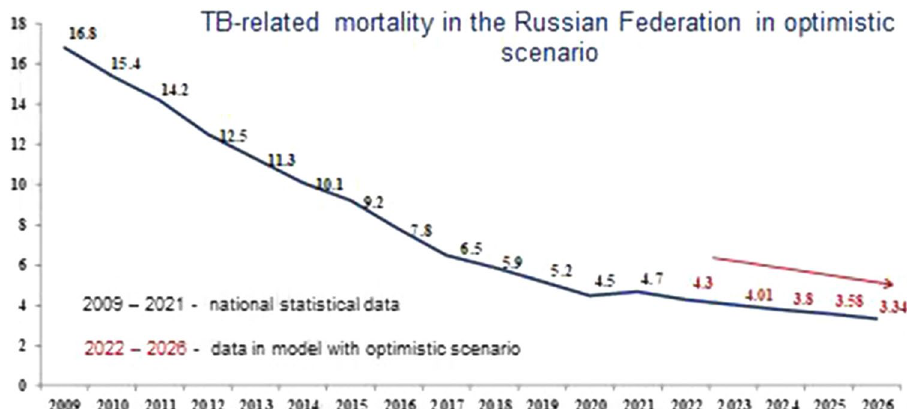
Fig. 9 Forecast of TB-related mortality in the Russian Federa- tion with the optimistic